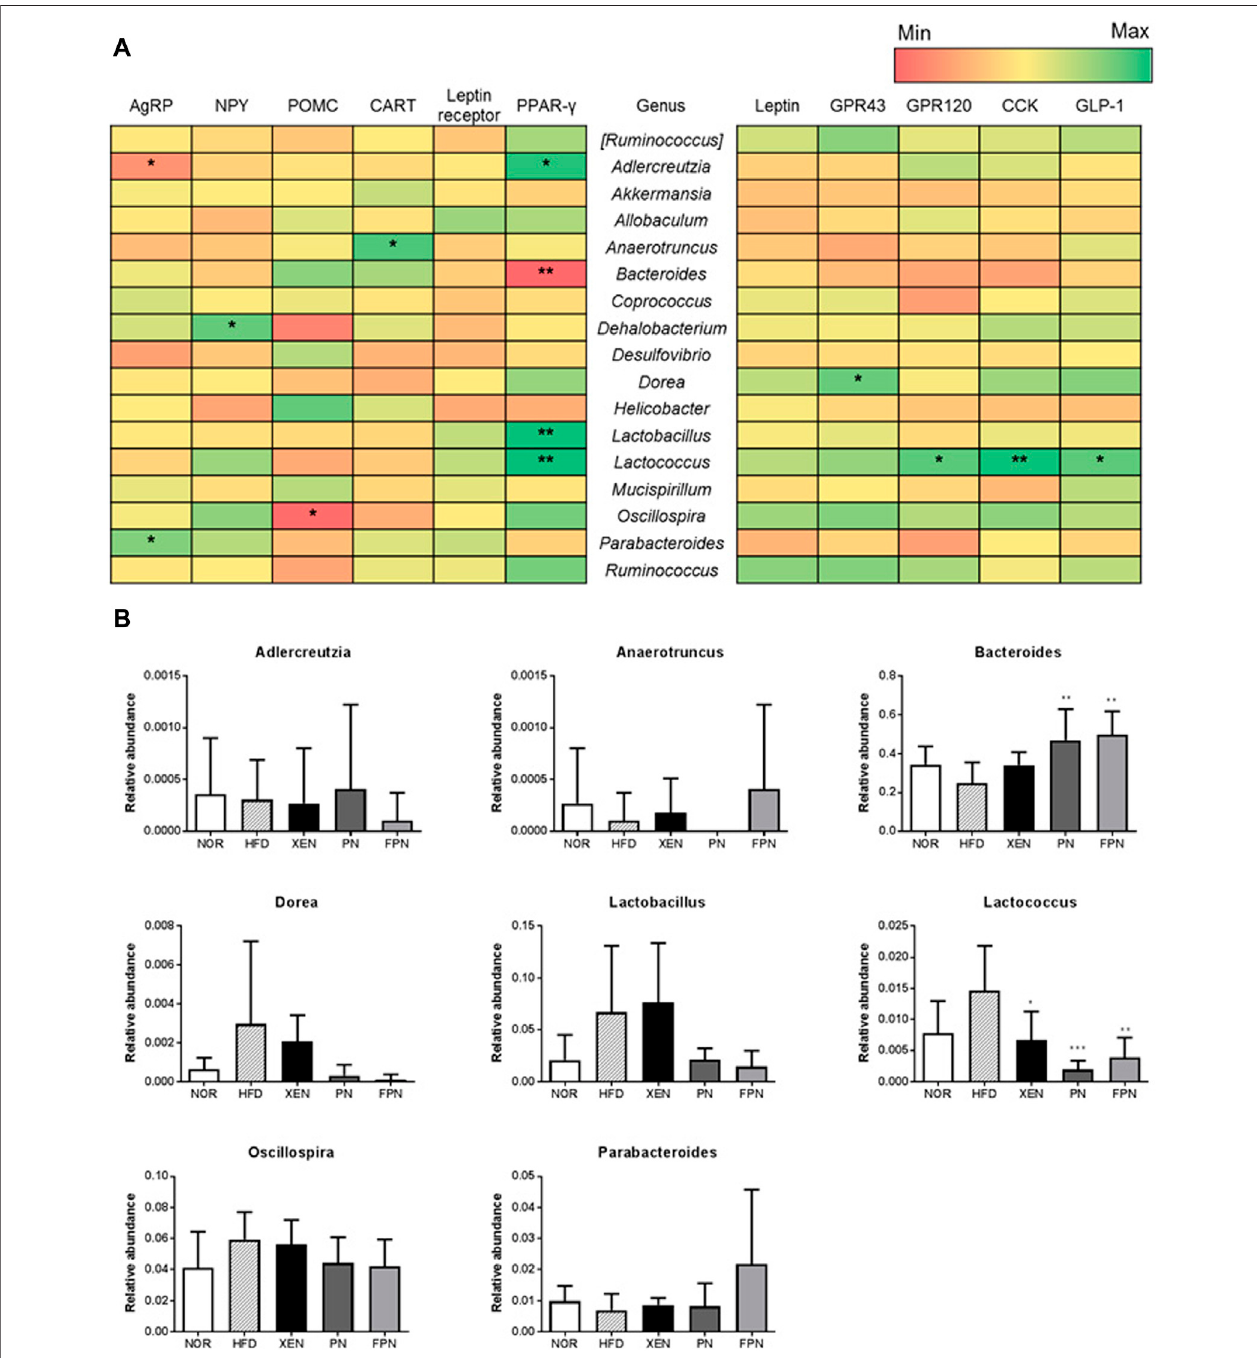
FIGURE 9 | Correlation between the gut microbiota and hypothalamic and colonic gene expressions of the satiety hormone leptin, appetite regulators, and gut hormonesintheHFD-inducedmousemodel afteratreatment for9 weeks. (A) Heatmap showingthecorrelationbetweenthegutmicrobialpopulation atthegenuslevel and theexpression levelsofgenesofappetite regulatorsandguthormones.ThePearsoncorrelationvalueswereusedforthematrix. * p < 0.05;** p < 0.01; *** p < 0.001. (B) The relative abundance of the bacterial genus correlated signi fi cantly with the gene expressions in the hypothalamus and colon. The data are expressed as the mean ± SEM ( n (cid:2) 7 – 8); * p < 0.05; ** p < 0.01; *** p < 0.001; HFD group vs. treatment groups (XEN, PN and FPN).